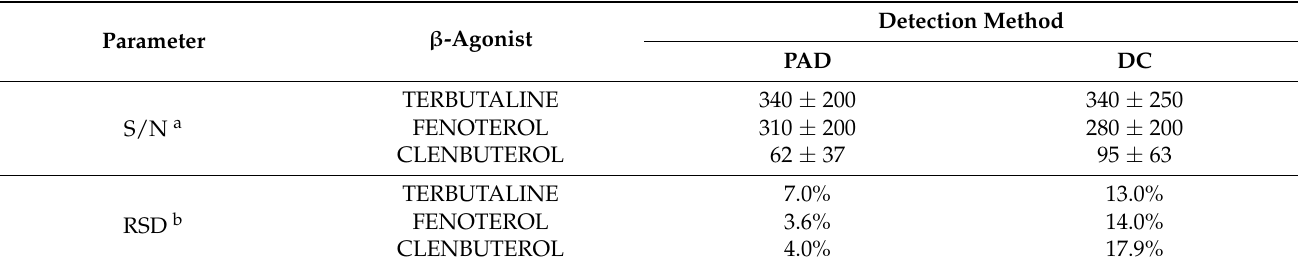
Table 3. Signal to noise ratio (S/N) and relative standard deviation of β -Agonists evaluated for PAD and DC detections in LC at GCE.